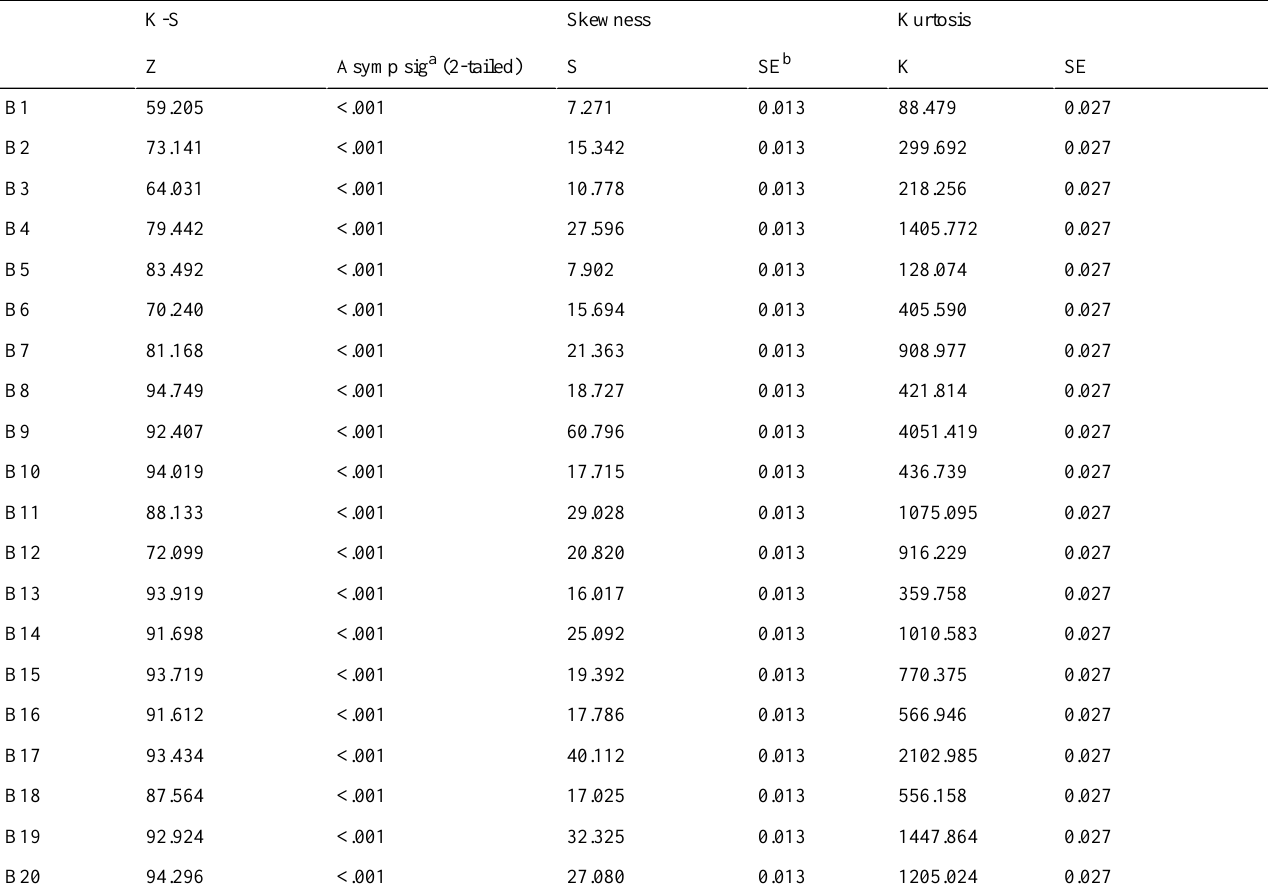
Table 1. Integration of the results including K-S, skewness, and kurtosis of variables (N=33,128). KurtosisSkewnessK-S SEKSE b SAsymp sig a (2-tailed)Z